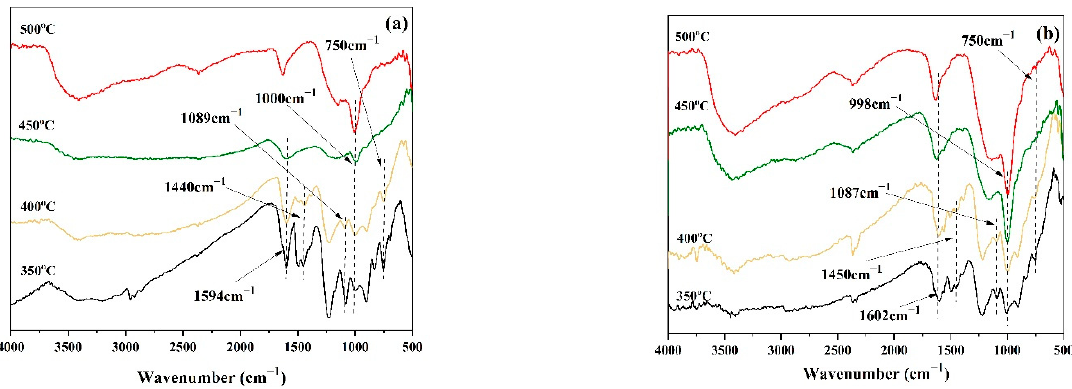
Figure 11. FTIR spectra of EP/15MAPP ( a ) and EP/15PPy-MAPP ( b ) under different heating temper- atures.